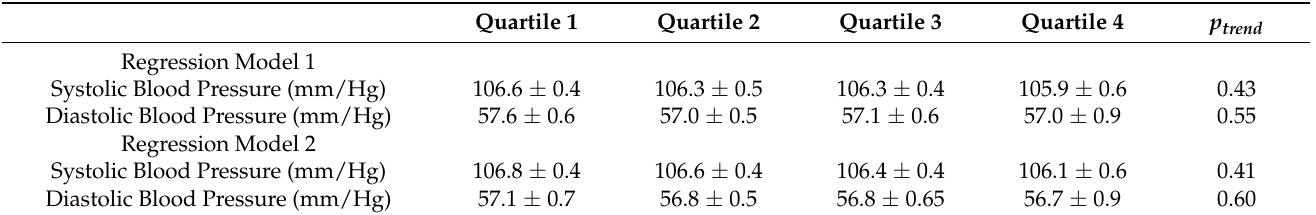
Table 2. Adjusted mean levels of blood pressure and metabolic biomarkers across sex-specific quartiles of plasma fluoride ( n =